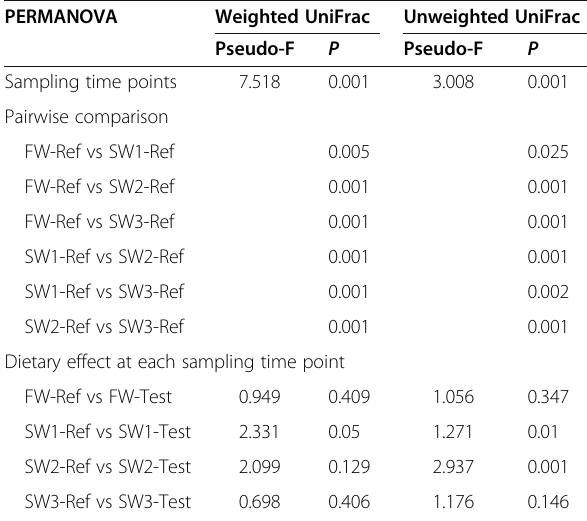
Table 1 Result of the PERMANOVA analysis of the weighted and unweighted UniFrac a